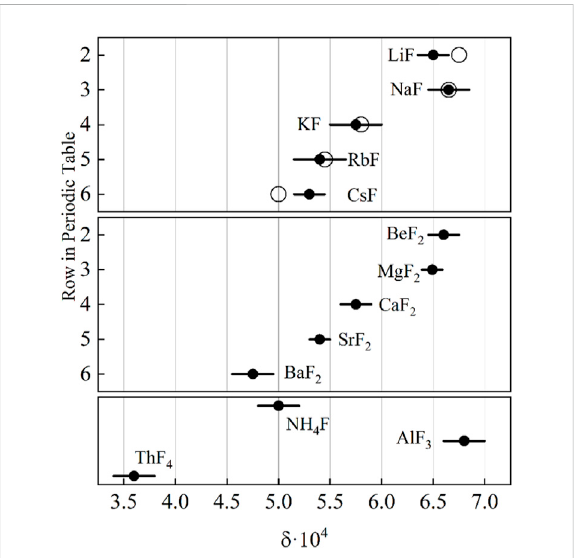
FIGURE 1 Chemical shift of the 19 F NMR signal in different fl uoride crystals, the black dots with the error bar are the experimental results, the circle is theoretical value calculated from